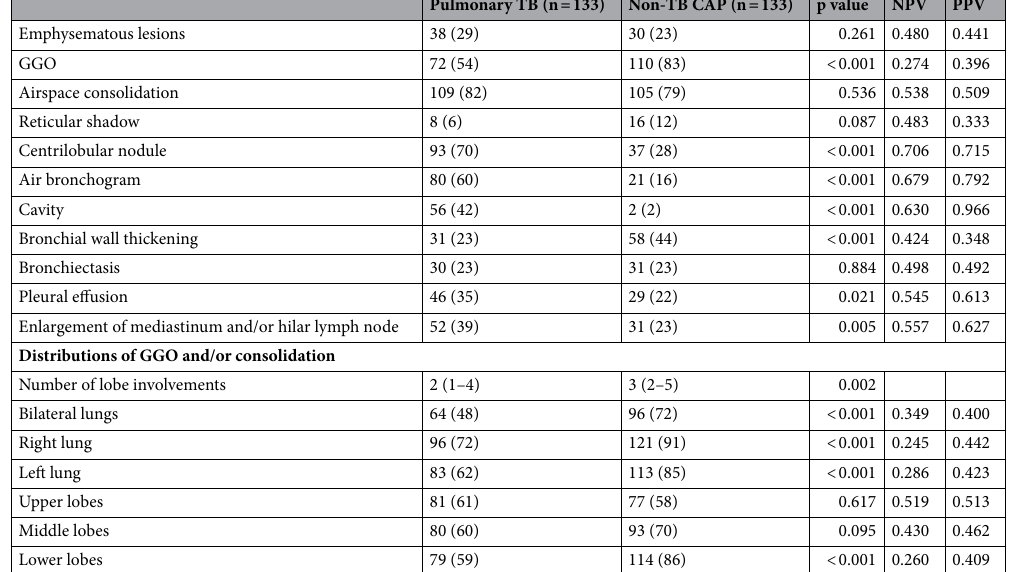
Table 3. High-resolution computed tomography (HRCT) features of elderly patients with pulmonary tuberculosis and those with non-tuberculosis CAP. Data are presented as number (%). CAP community- acquired pneumonia, TB tuberculosis, NPV negative predictive value, PPV positive predictive value, GGO ground-glass